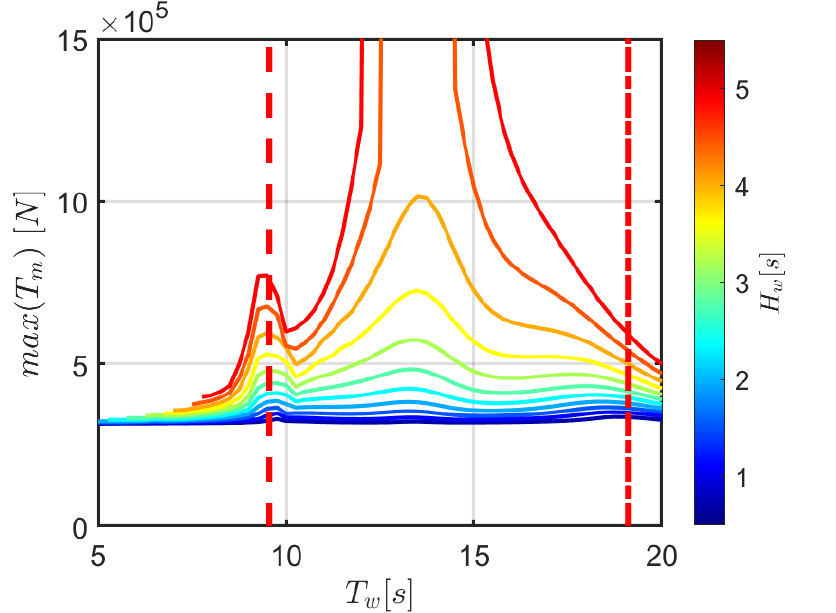
Figure 8. Peak tension of the front mooring at the fairlead as a function of T w , for different H w . The dashed and dash-dotted red lines correspond to T w = 1